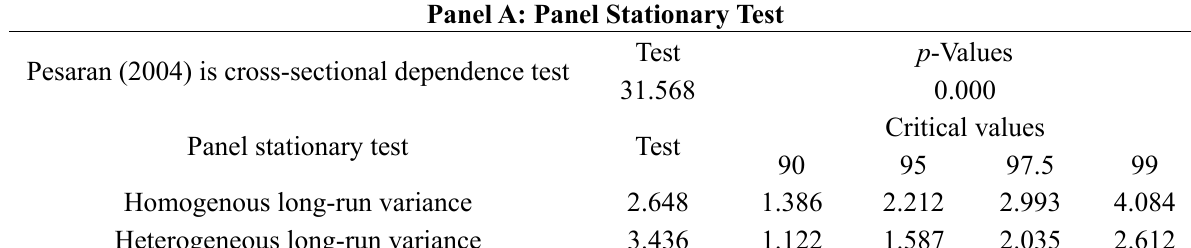
Table 2. Panel stationary test with sharp and smooth breaks. Panel A: Panel Stationary